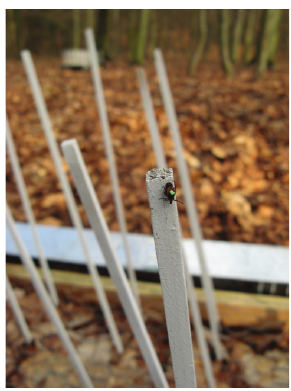
Figure 2: Dorsally marked adult female Ixodes ricinus questing on a wooden rod placed in a field plot for observation of I. ricinus questing activity in a Germany (Berlin) forest (Dautel et al. 2008 [37], with permission from International Journal of Medical Microbiology